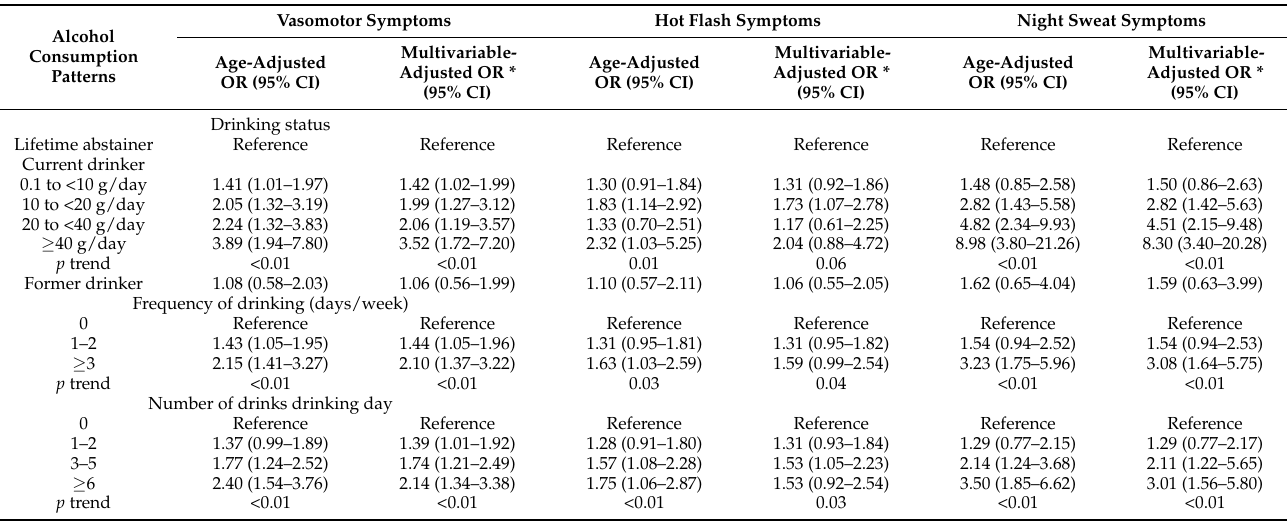
Table 2. Association between alcohol consumption and prevalence of early-onset, moderately-to- severely bothersome VMS (overall and each component including hot flash or night sweat) among premenopausal women ( n =